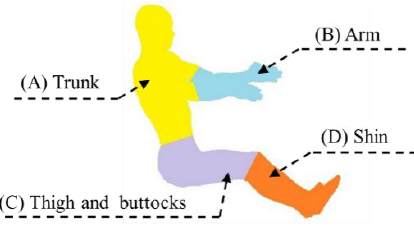
Figure 4. The f measurement positions according to the IEC TS 62764 standard.